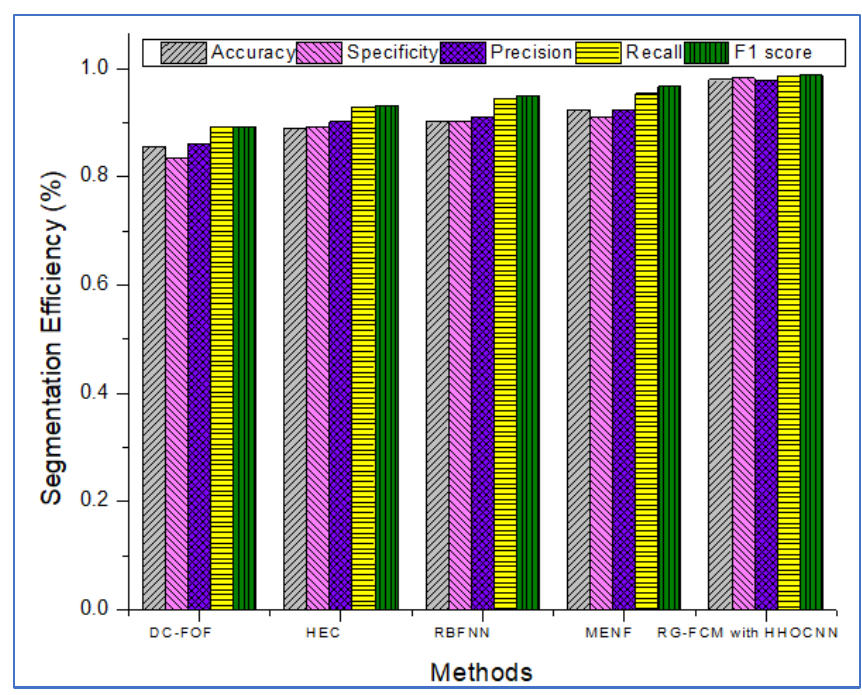
Figure 3. Segmentation Efficiency. Table 3. Brain Tumor Segmentation Efficiency.